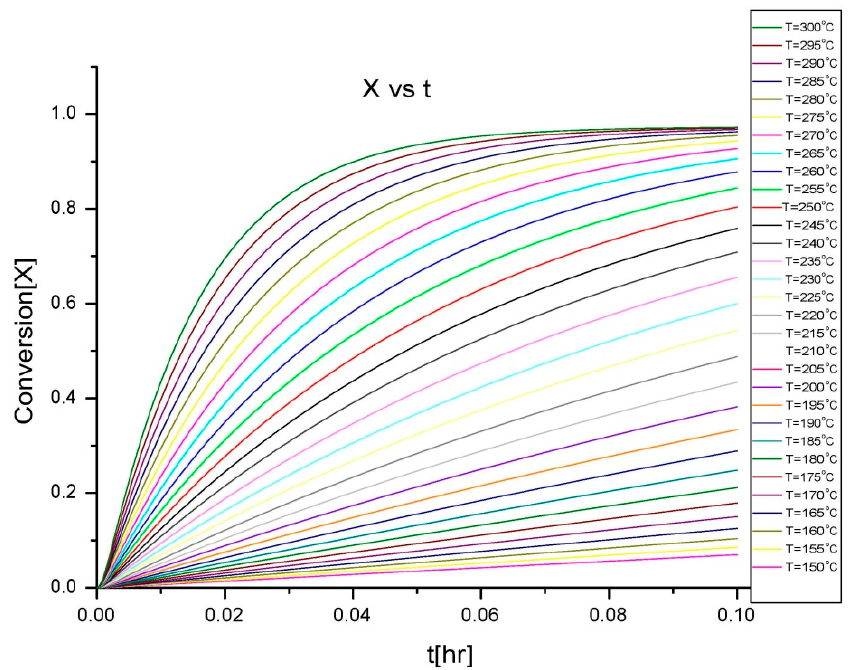
Figure 5. Isothermal curves for conversion ( X ) vs. t .